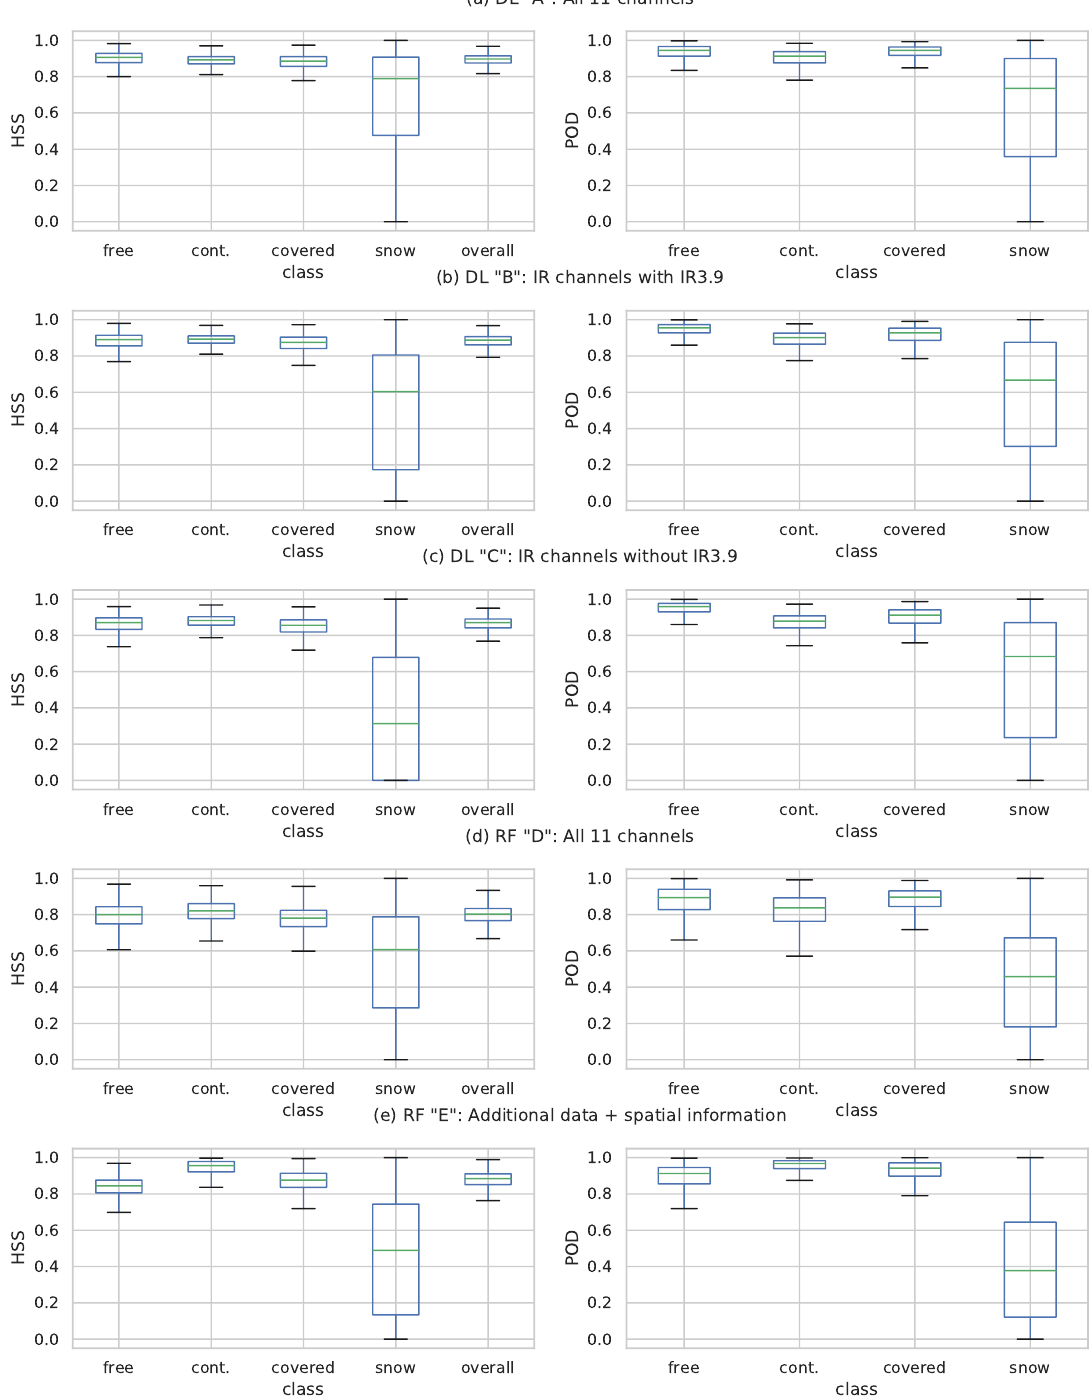
Figure 7. Box-plots of HSS and POD generated from all results of 7977 test scenes. HSS for all scene pixels is also